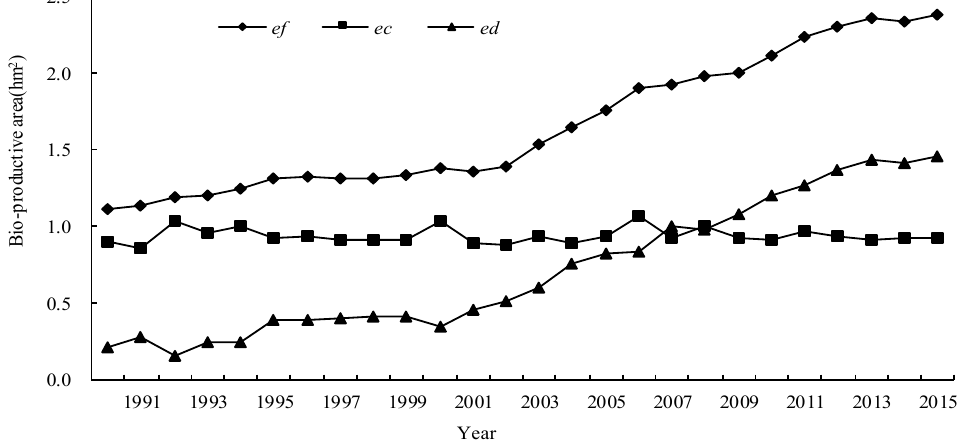
Figure 2. Dynamic changes of the ecological footprint and biocapacity per capita. ef is the ecological footprint per capita; ec is the biocapacity per capita; ed is the ecological deficit per capita.